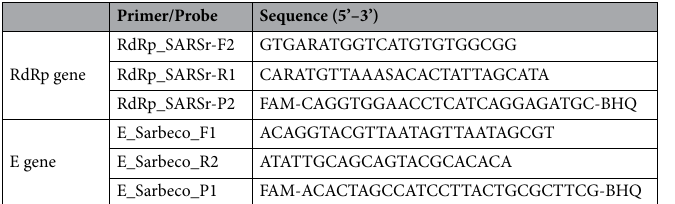
(Table 2)—and five samples showing negative results for a known respiratory virus were used as template. Sensitivity of the RT-qPCR assay was measured by RT-qPCR using plasmids containing cloned target SARS- CoV-2 genes (RdRp and E), which were serially diluted tenfold from different initial concentrations. To examine the responsivity of the assay, RT-qPCR was also performed using tenfold serially diluted RNA extracted from a lower respiratory tract sample of the first patient who tested positive for COVID-19 in Republic of Korea.